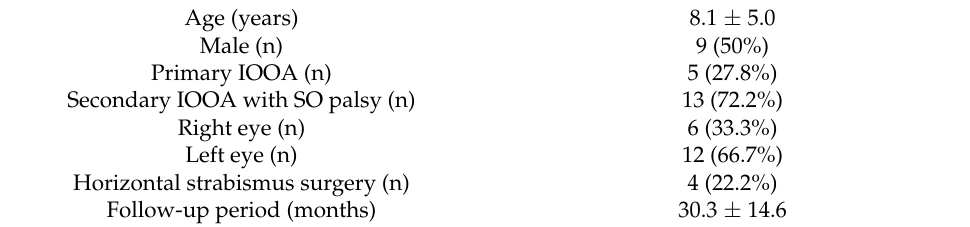
Table 1. Demographics of patients.